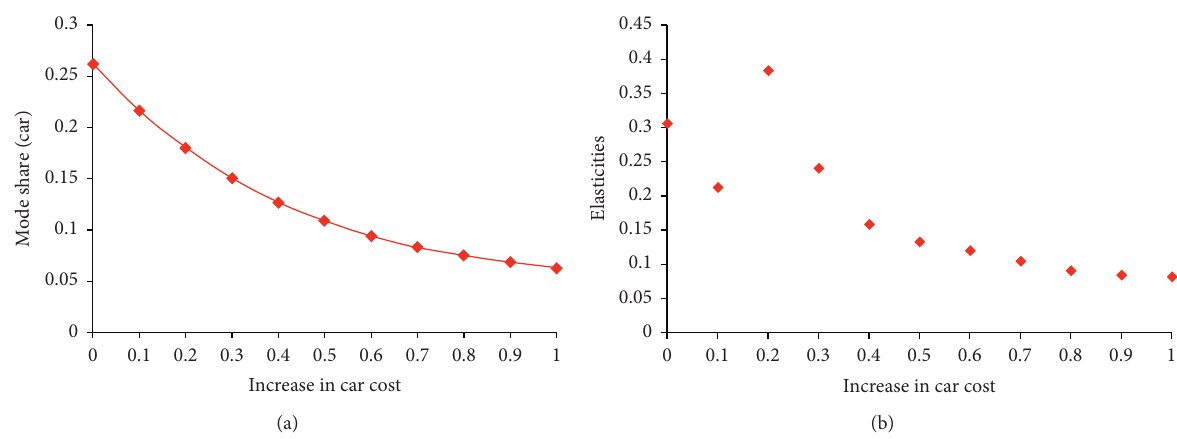
Figure 4: Effect of high car cost on mode choice probability. (a) Mode share (car). (b)